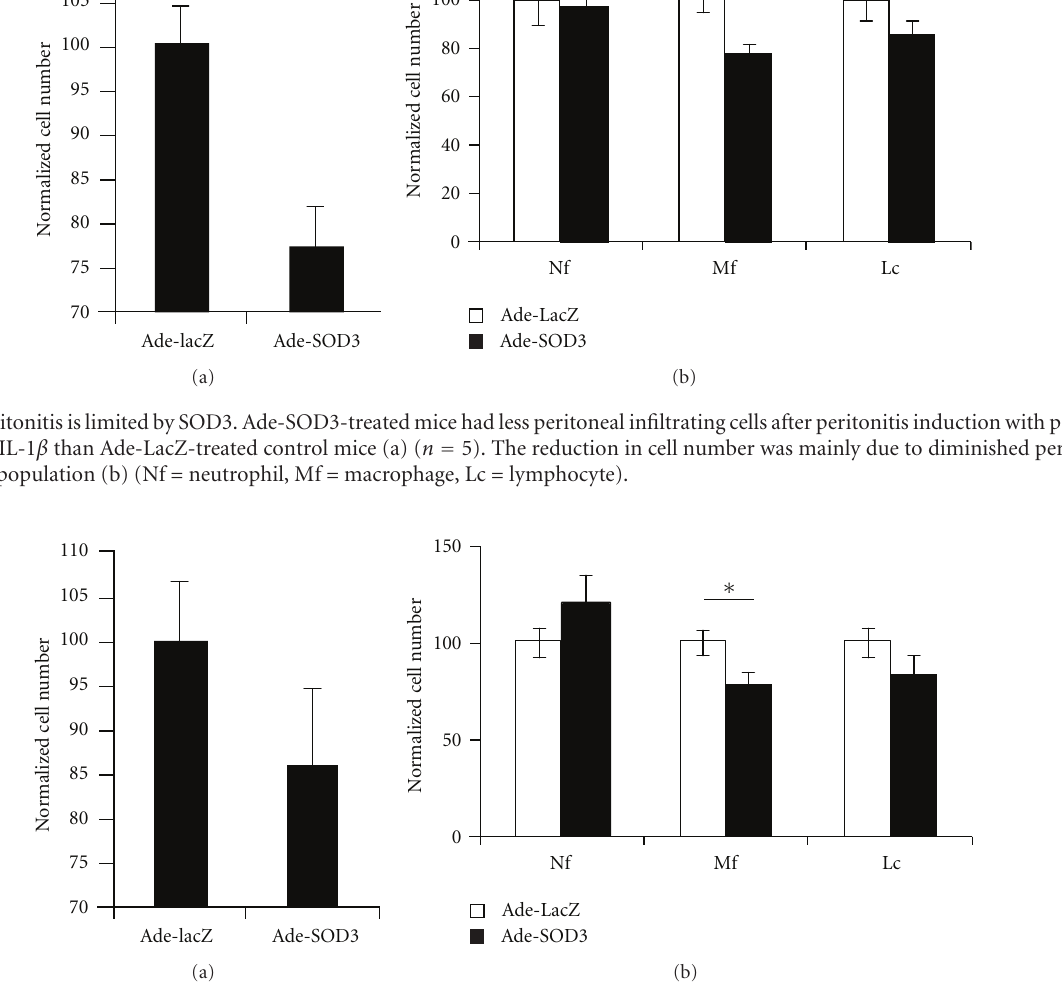
after virus injection and 18 hours after peritonitis